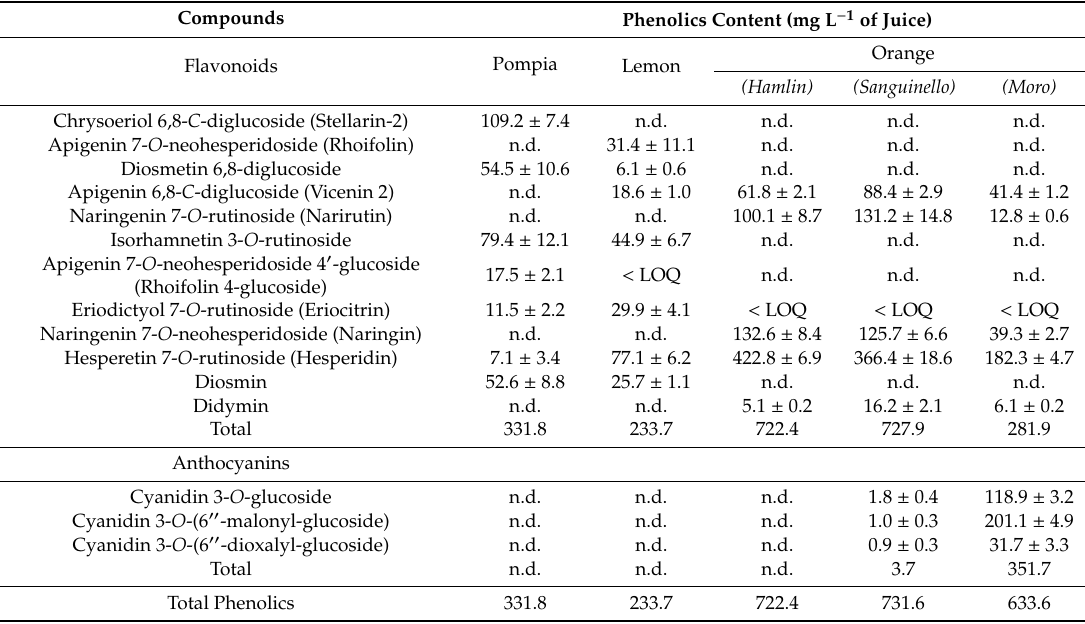
n.d. = not detected; LOQ = limit of